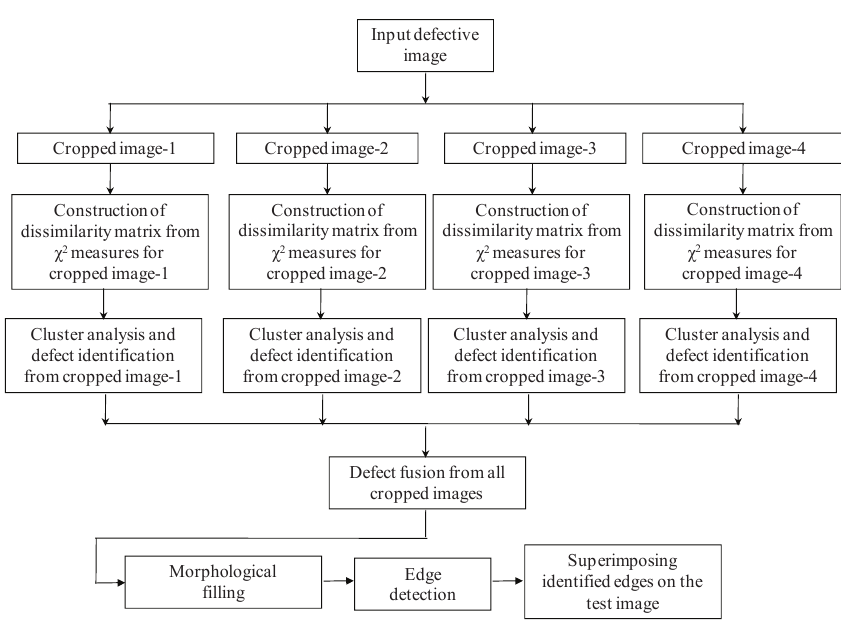
Figure 2. Defect detection scheme based on chi-square histogram